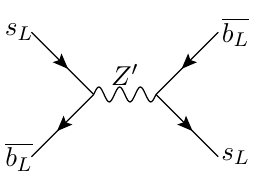
Figure 2 . Feynman diagram of the tree-level Z 0 contribution to B s (cid:0) B s